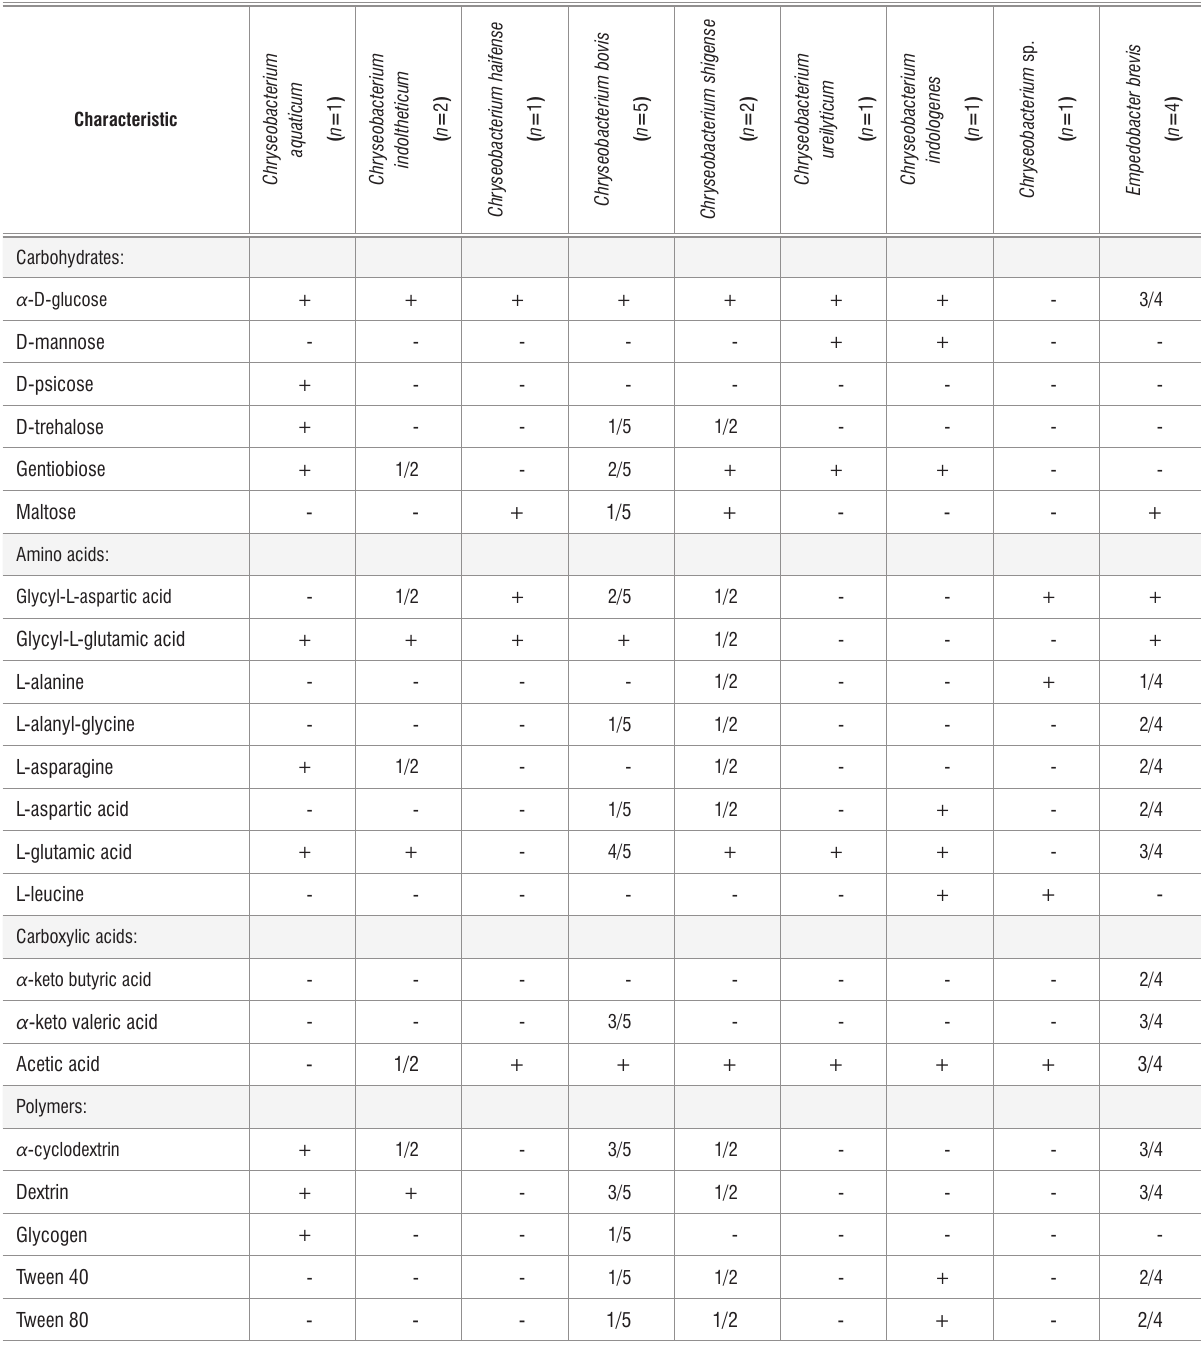
Table 4: Characteristics of the 18 dairy isolates indicating possible spoilage potential according to BIOLOG substrate utilisation